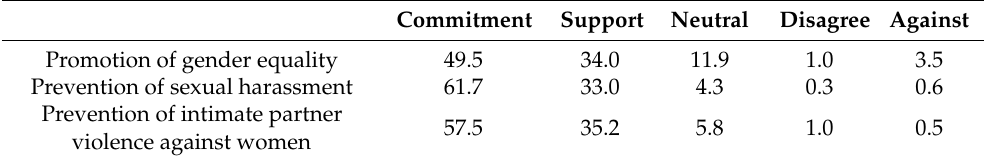
Table 3. Managers’ commitment to preventing gender violence in companies